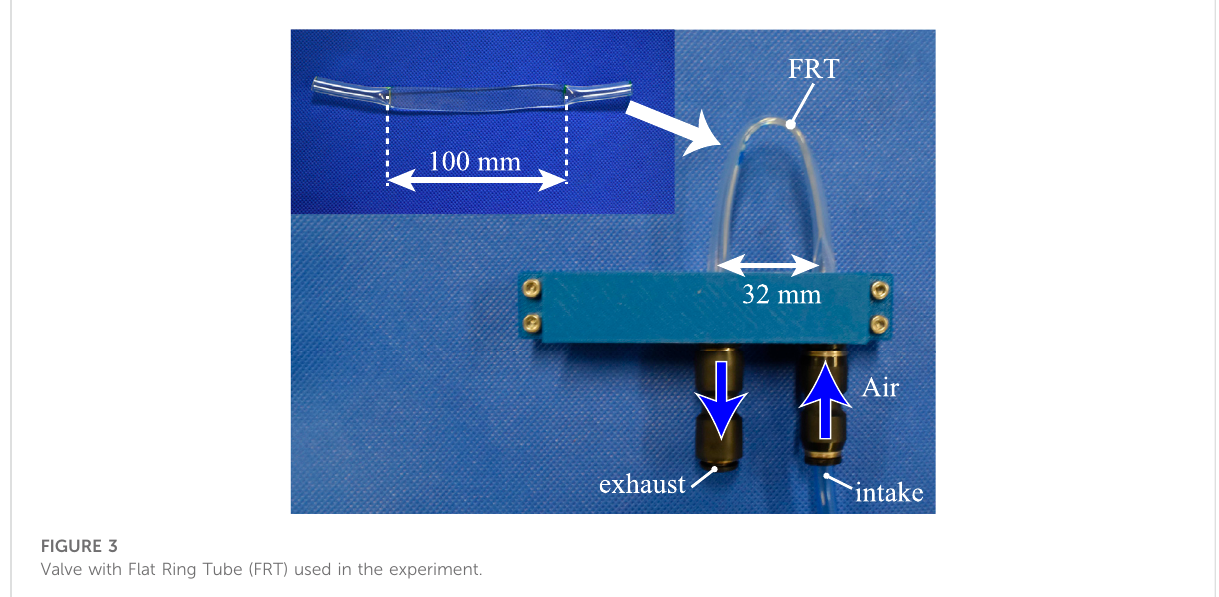
FIGURE 3 Valve with Flat Ring Tube (FRT) used in the experiment.